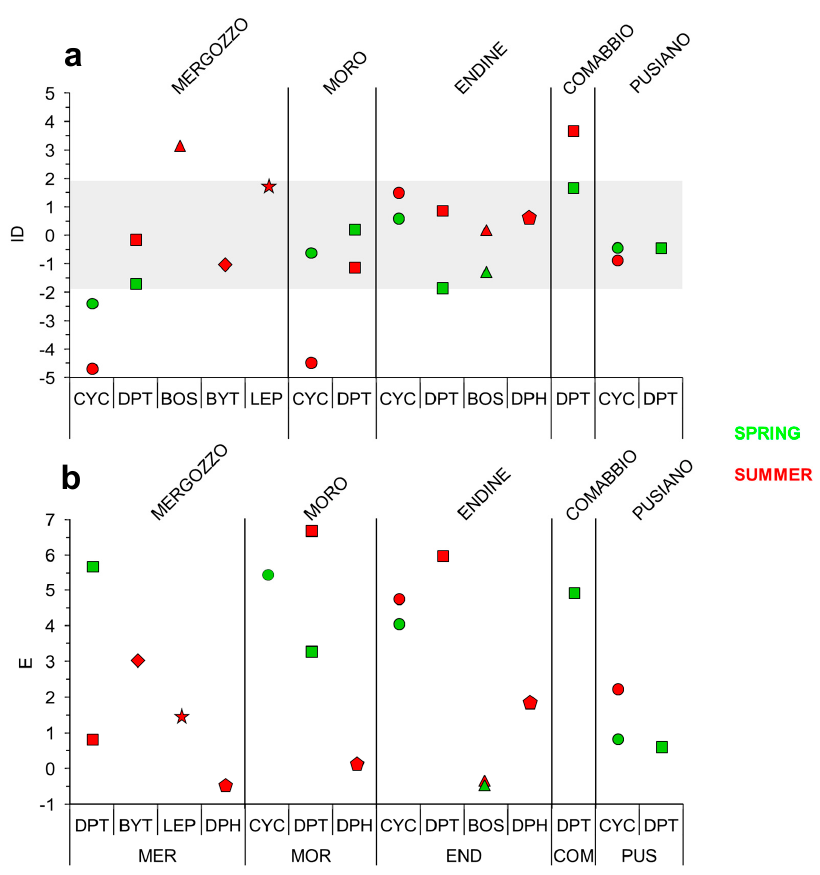
Figure 4. ( a ) Carbon isotopic distance (ID) of zooplankton taxa with respect to the baseline ( Daphnia ) in the studied lakes. ID values ranging between − 1.9 and +1.9 are highlighted by the grey bar; ( b ) Nitrogen enrichment (E) of zooplankton taxa relying upon lake pelagic baseline ( Daphnia ). CYC: cyclopoids; DPT: diaptomids; BOS: Bosmina ; DPH: Diaphanosoma ; BYT: Bythotrephes ; LEP: Leptodora . A full overlapping between Daphnia and Bosmina and a close similarity with Diaphanosoma